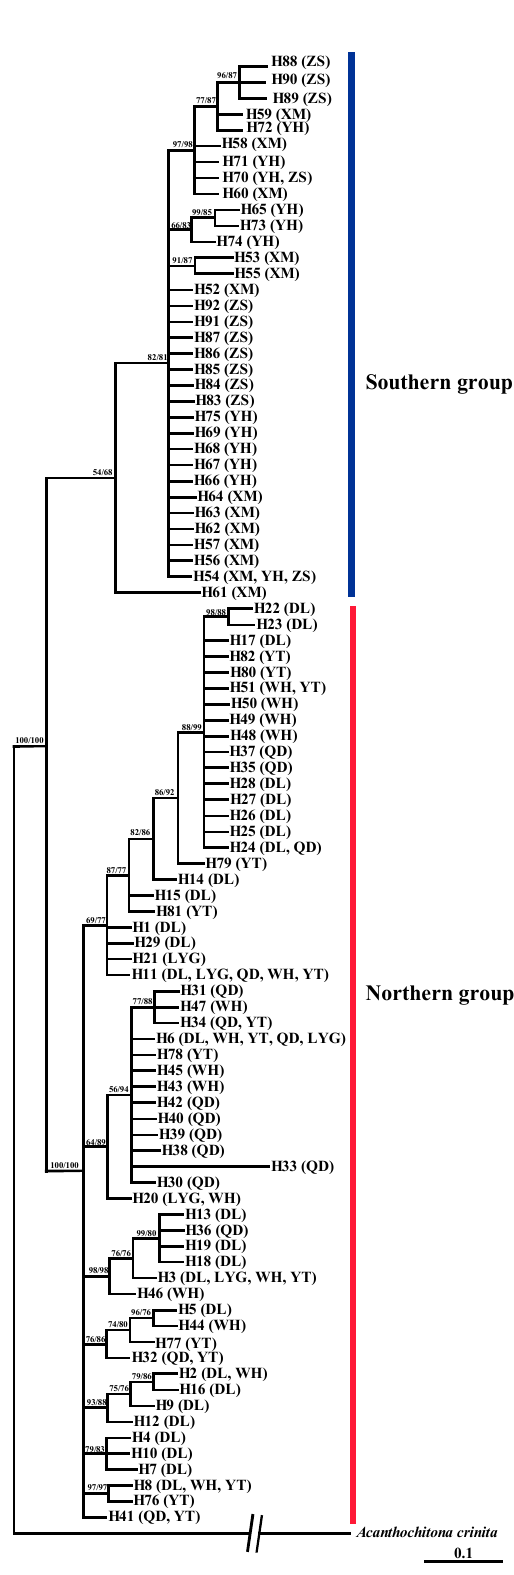
Figure 2. Phylogenetic tree based on combined sequences of COI and 16S rRNA segments of A. rubrolineatus . The posterior probability values of the Bayesian method (before the slash) and the bootstrap values of the ML method (after the slash) were showed.